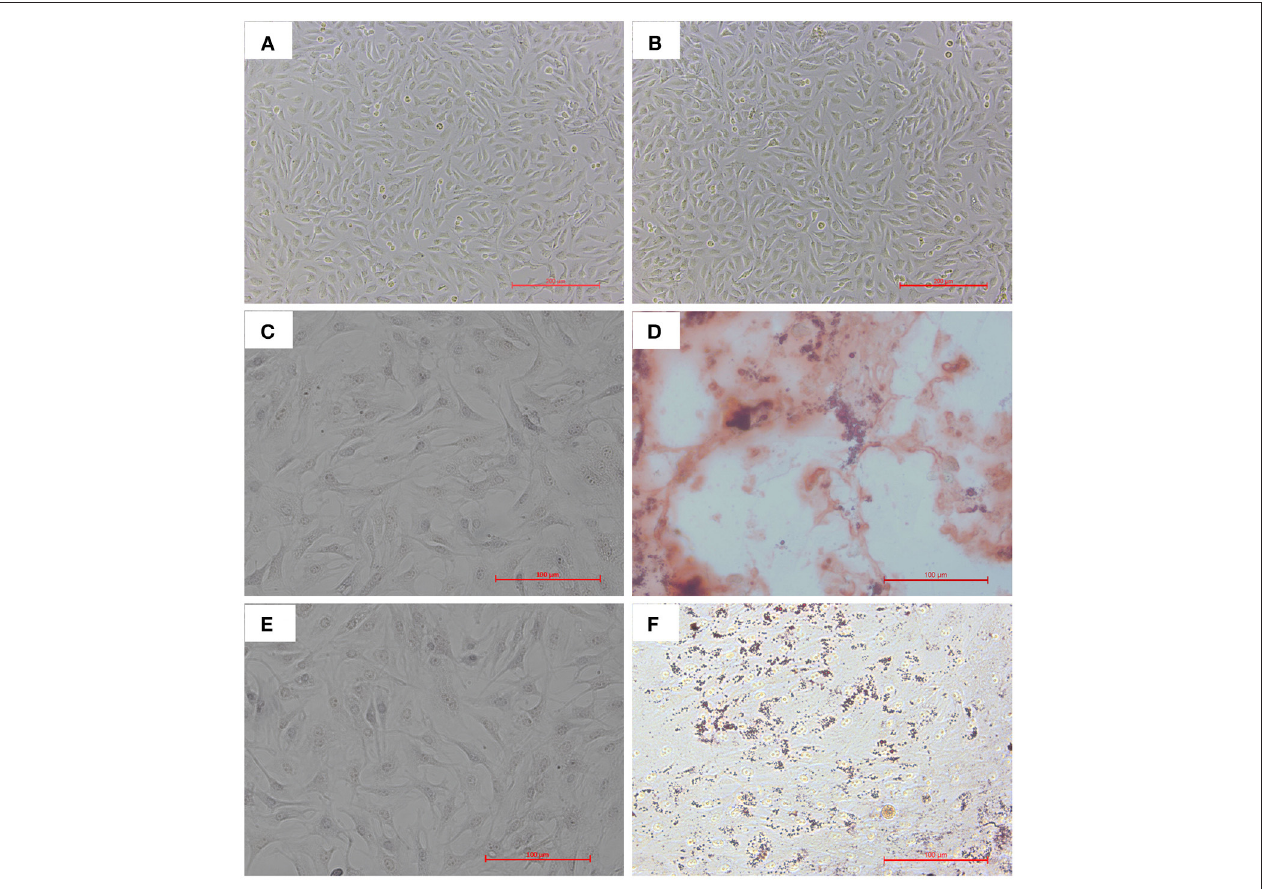
FIGURE 1 | Cultivation and differentiation of bAD-MSCs. (A,B) Cell morphology of different parts at P0 and P4. (C,D) Osteogenic differentiation after 21 d showing calcium deposits stained with Alizarin Red S (C is control). (E,F) Adipogenic differentiation after 21 d showing lipid droplets stained with Oil Red O (E is control) (Scale bar = 200 µ